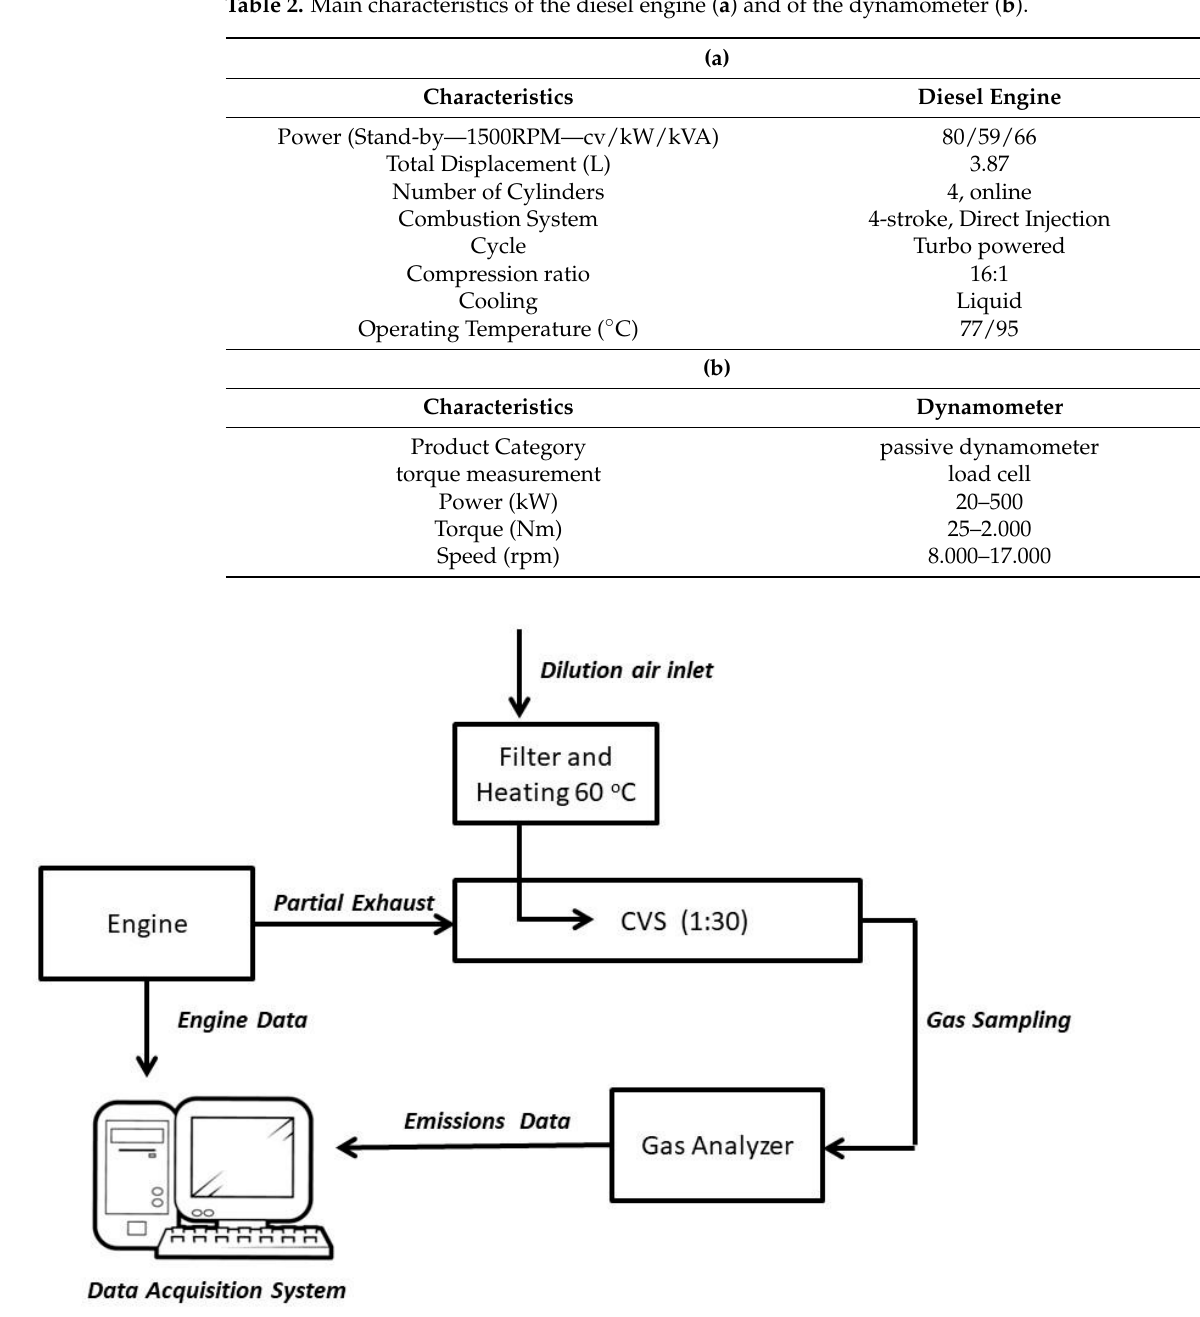
Table 2. Main characteristics of the diesel engine ( a ) and of the dynamometer ( b ).